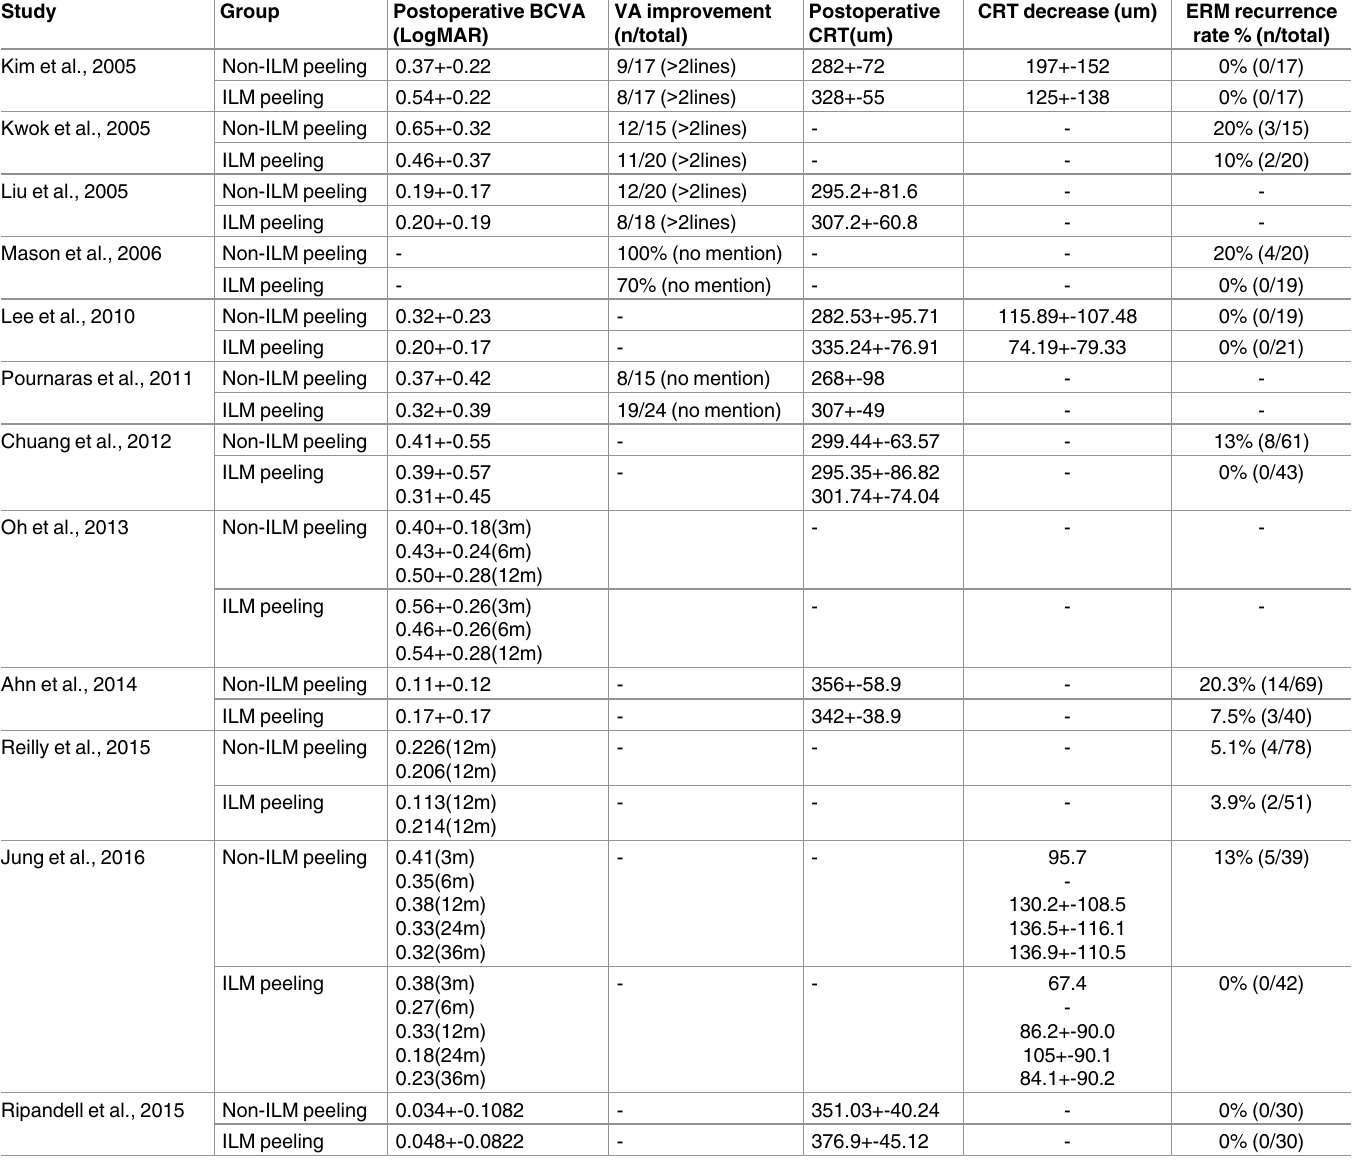
Table 2. Summaryof studies included in the